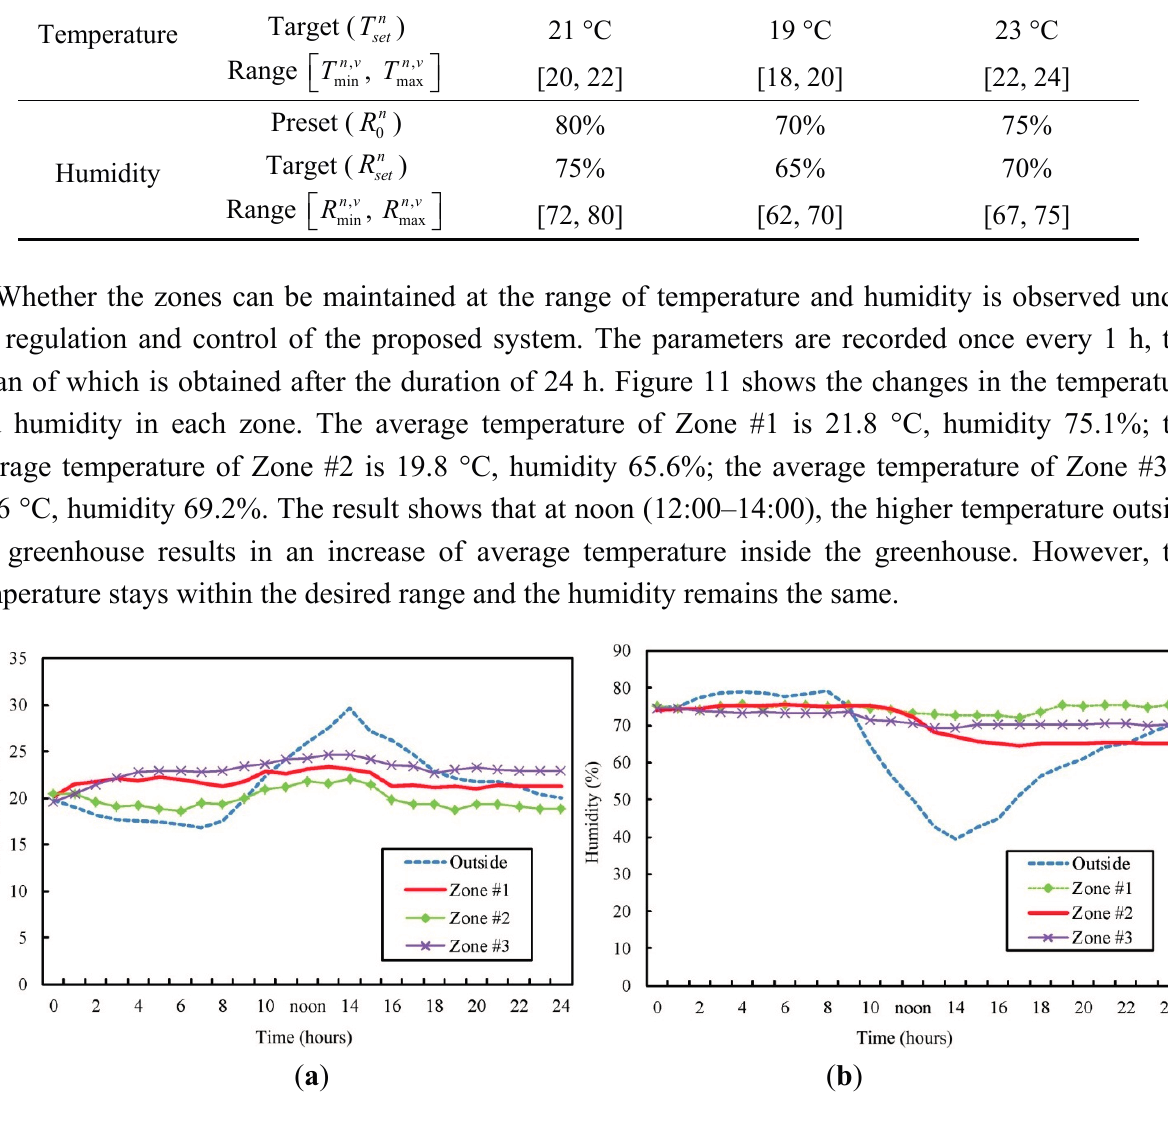
Figure 11. Comparisons of diurnal changes of parameters in each zone; ( a ) temperature; ( b )